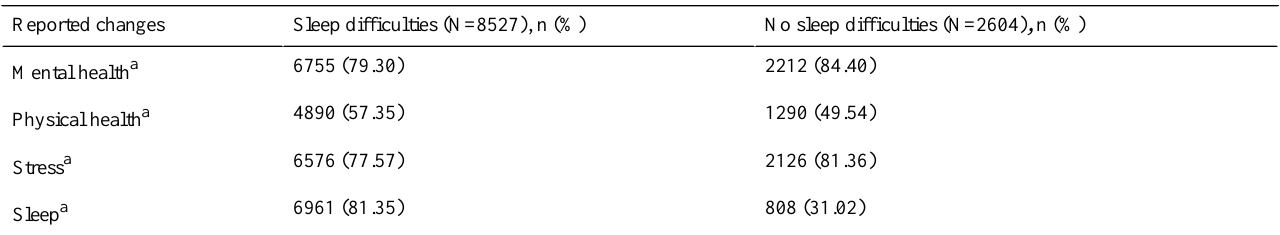
Table 8. Differences in noticing changes in mental health, physical health, stress, and sleep based on reported sleep difficulties